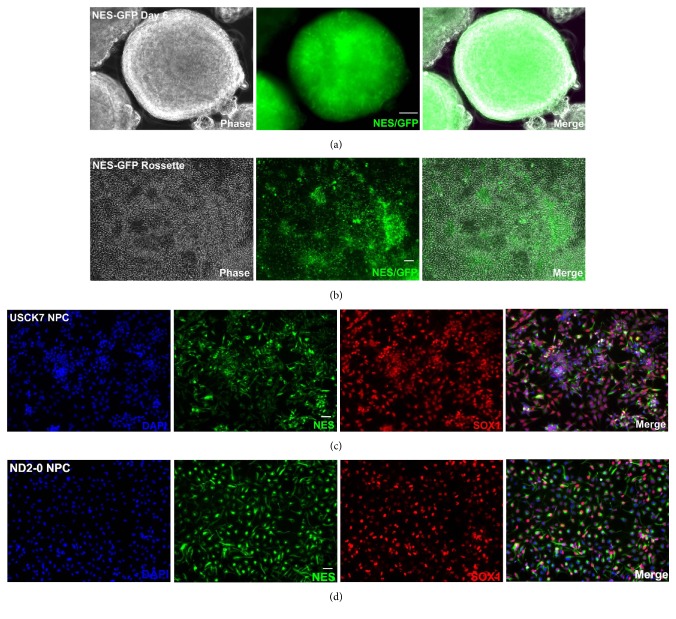
Generation of NPCs from hiPSCs. Representative images of neural tube structures generated from differentiating NES-GFP reporter hiPSC line via embryoid body formation method on day 6. GFP serves as a surrogate marker for NESTIN, a widely accepted NPC marker (a). The neural rosettes were attached to culture plates on day 10 as monolayer culture which continued to express GFP (NESTIN) (b). Similarly, NESTIN and another NPC marker SOX1 were both expressed robustly and uniformly in NPCs that were derived from two additional hiPSC lines, USCK7 (c) and ND2-0 (d), as revealed by immunocytochemistry staining of both NESTIN (green) and SOX1 (red). DAPI (blue) was used to reveal nuclei. Bar, 50 μm.